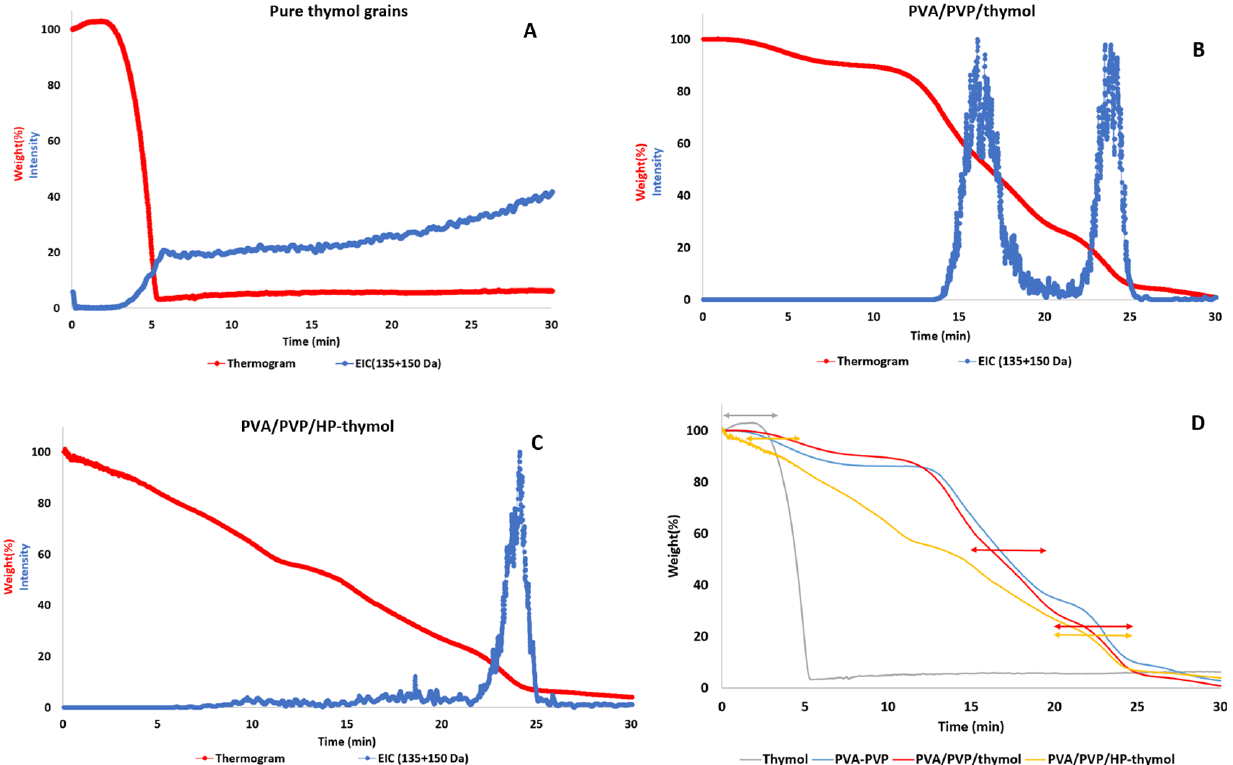
Figure 8. TGA-MS of pure thymol grains ( A ). Comparative graphs of thymol alone and combined with HP entrapped in PVA/PVP hydrogel ( B and C , respectively). Thermograms of weight loss as a function of time ( D ) of thymol (grey), neat PVA/PVP hydrogel (blue) and hydrogels loaded with thymol solely (red) or combined with HP (orange).